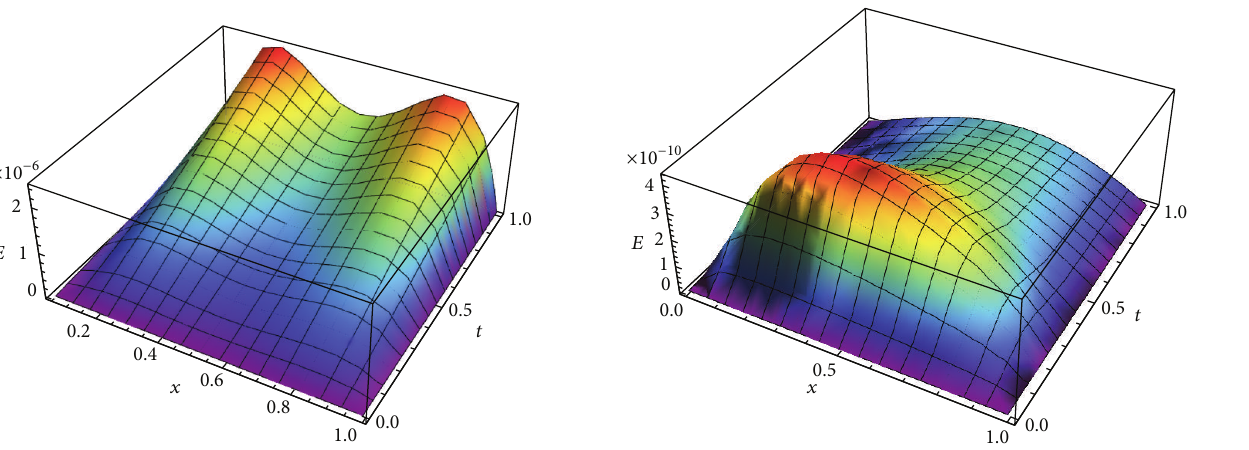
Figure 3: The absolute error of problem (35) where −𝛼 = 𝛽 = 1/2 , ] = 𝜂 = 𝛾 = 10 −3 , and 𝑁 = 4 for 𝛿 = 3 .